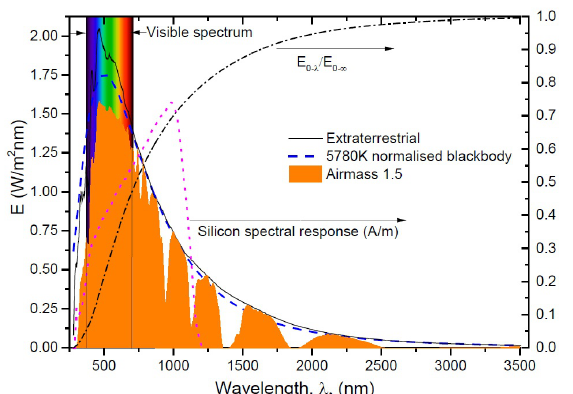
Figure 1: Spectral properties of solar radiation outside the earth’s atmosphere with normalized blackbody spectrum with a peak at the same wavelength as that for extraterrestrial radiation. The filled curve is the global air mass 1.5 spectrum on earth. Also plotted on the right axis is the cumulative solar energy, E 0 − λ , normalized by the total solar energy, E 0−∞ , and the spectral response of a silicon photovoltaic cell expressed in